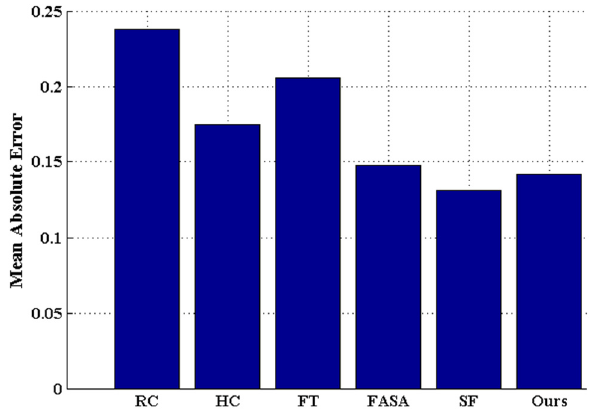
Figure 12. Mean absolute error to ground truth.